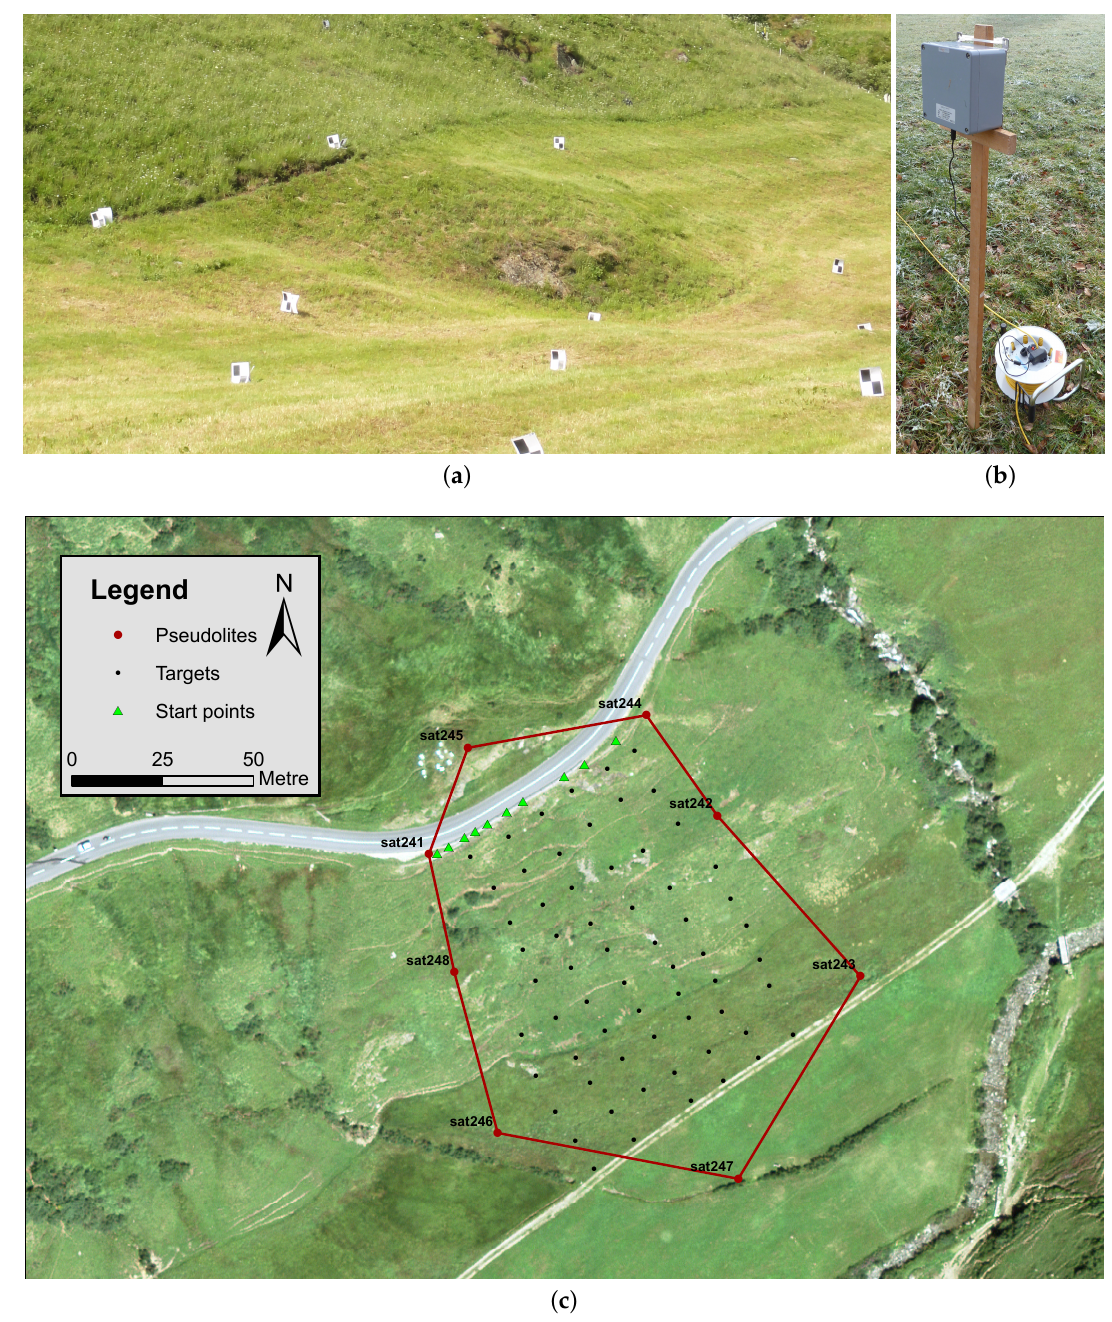
Figure 4. Enhancement of rockfall test site with ( a ) b/w targets for video analysis; ( b ) Wi-fi devices (pseudolites) to receive radio signals emitted from test blocks; ( c ) Distribution of targets and pseudolites at test site (source: